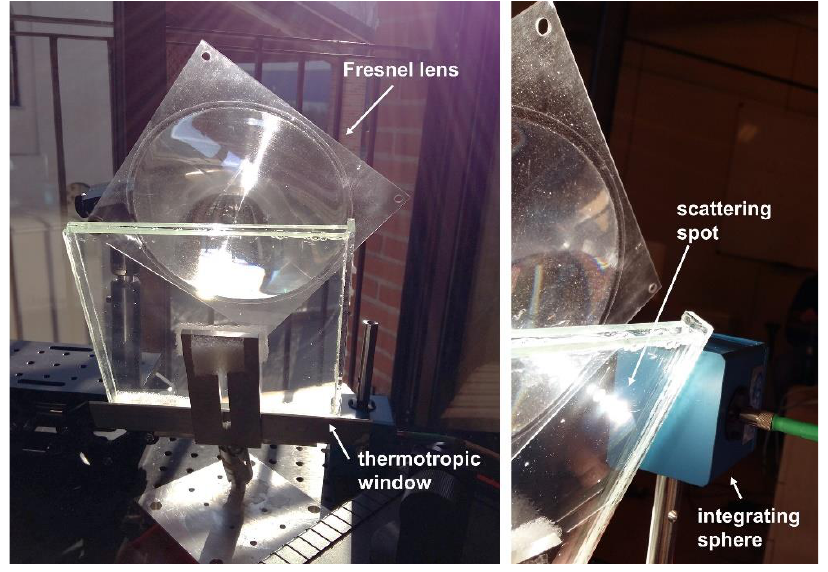
Figure 7. Setup for solar concentration experiments.